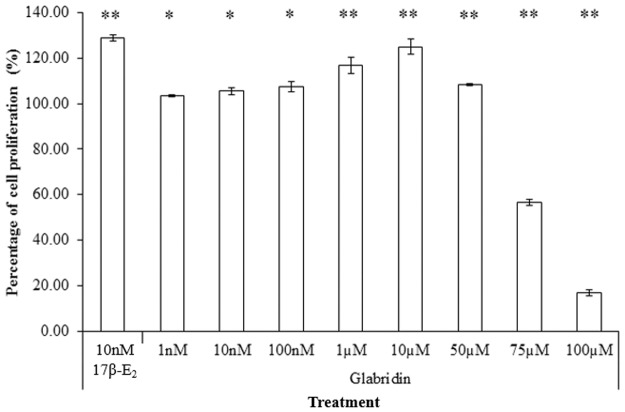
Effect of varying concentrations of glabridin in comparison to 1nM 17β-E2.The values represent the mean activity of three treatment group. *P<0.05 and ** P≤0.01 against the untreated control.